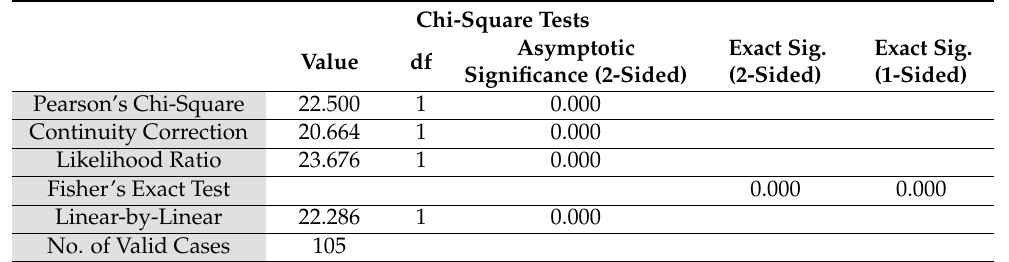
Table 3. Statistical significance of the